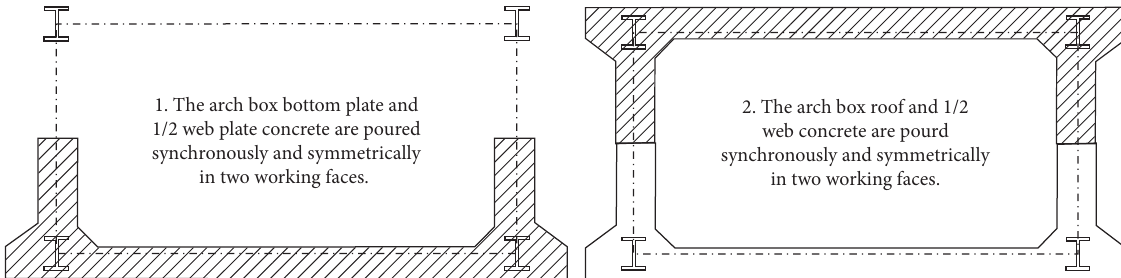
Figure 14: Sequence diagram of the lateral pouring of the outer concrete on the top of the arch ring.